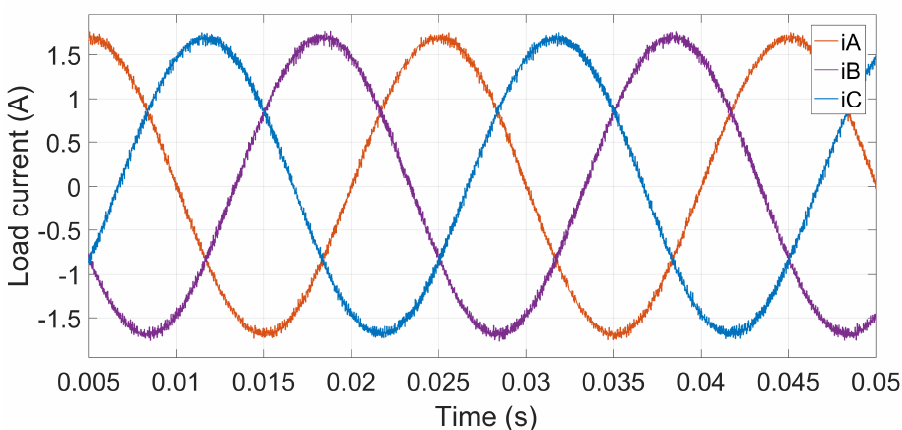
Figure 11. The load current waveform of the FS-PDCC controlled three-phase VSI for T s = 20 μs.